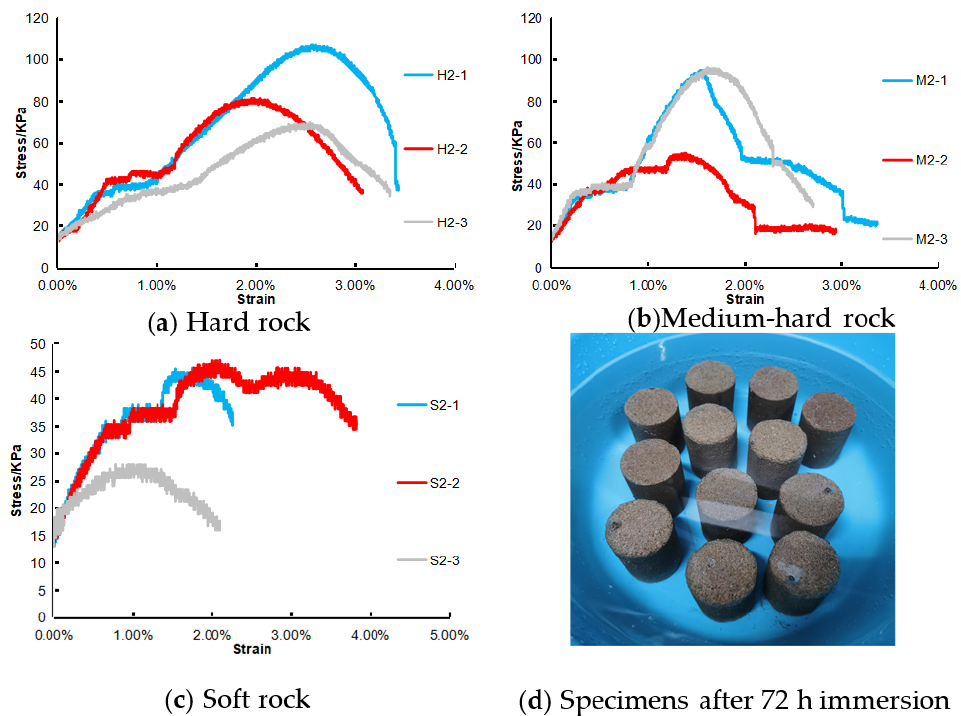
Figure 3. Immersion characteristics and complete stress–strain curve of rock specimens.